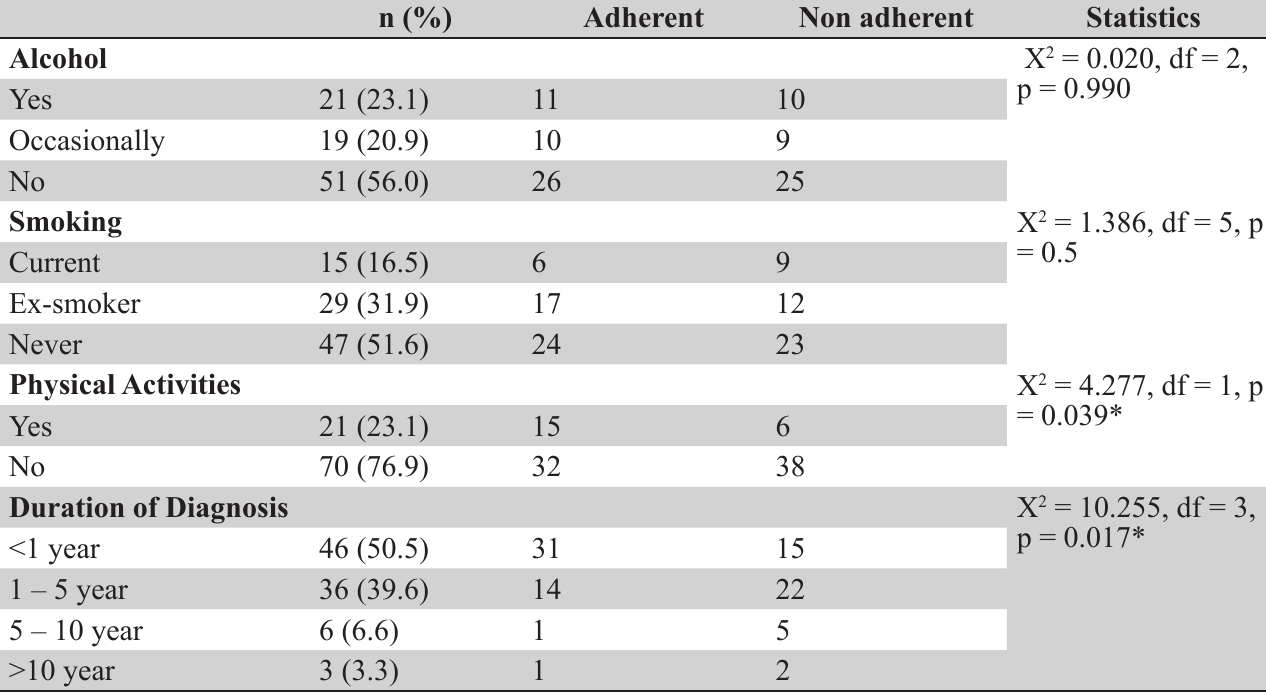
Table 2. Lifestyle variables and Adherence to treatment (N = 91). n (%) Adherent Non